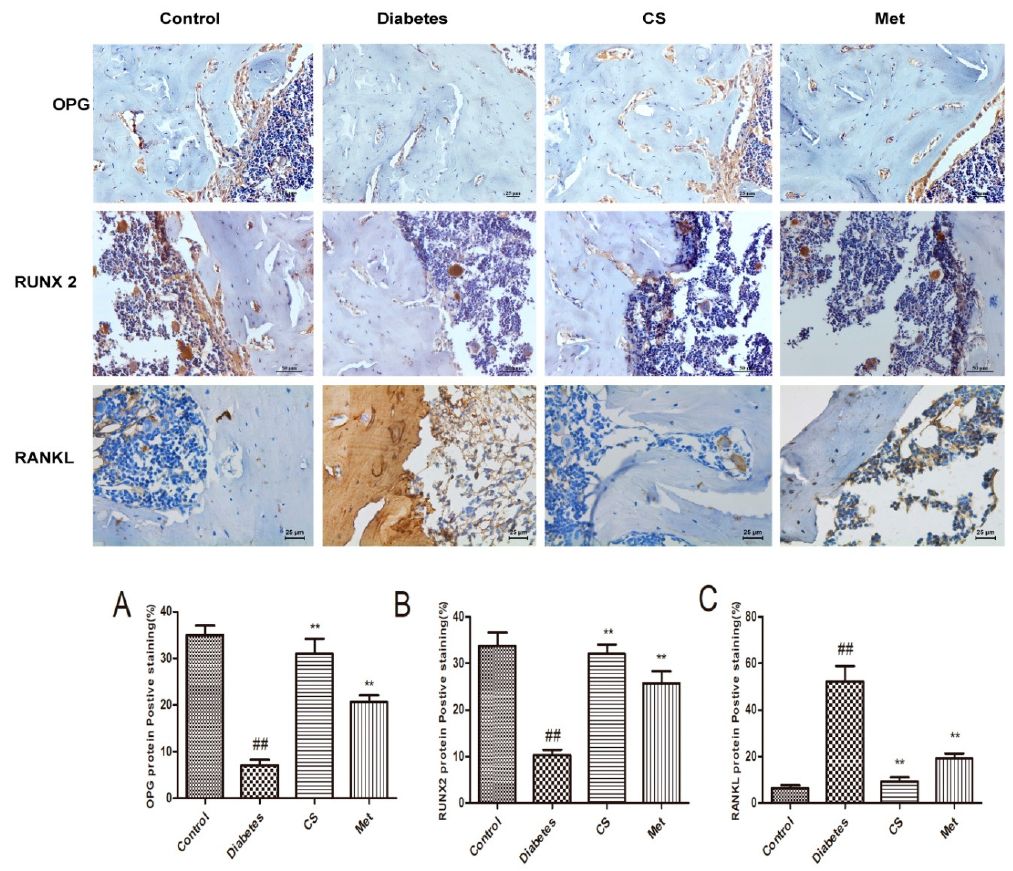
Figure 8. Proteins (OPG, RUNX 2 and RANKL) in the femurs of each group rats at the end day of experiment, immunohistochemical staining, magnification, 400 × . ( A ) Positive-staining area of OPG in each group; ( B ) positive-staining area of RUNX 2 in each group; ( C ) positive-staining area of RANKL in each group. ## p < 0.01 compared with the control group; ** p < 0.01 compared with the diabetic group.